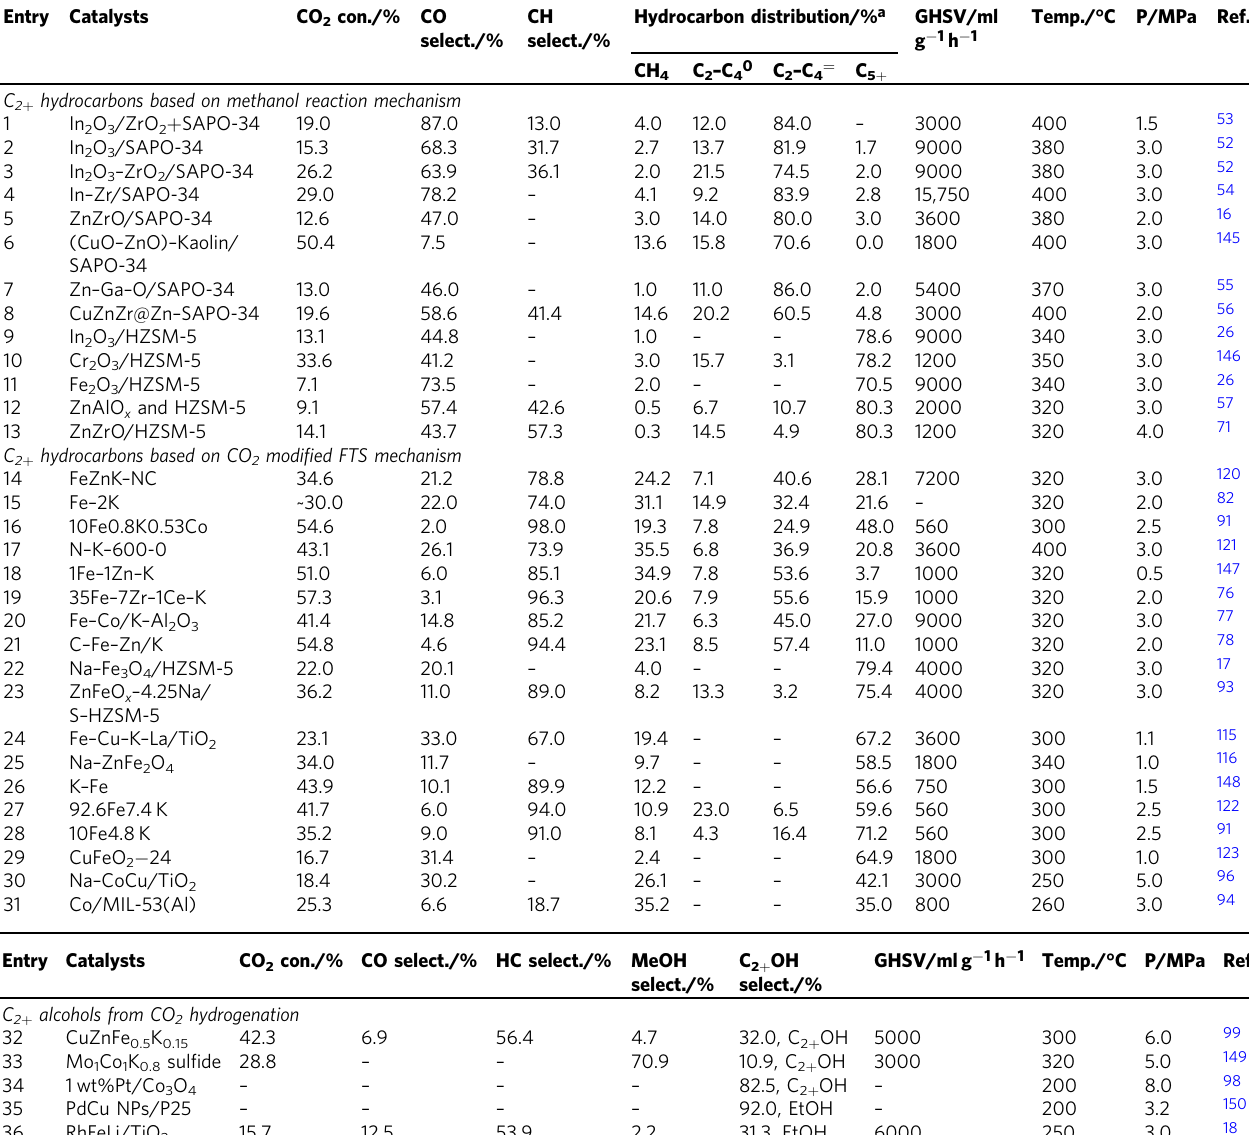
Table 1 Representative catalysts and their performance for hydrogenation of CO 2 to C 2 + species. Entry